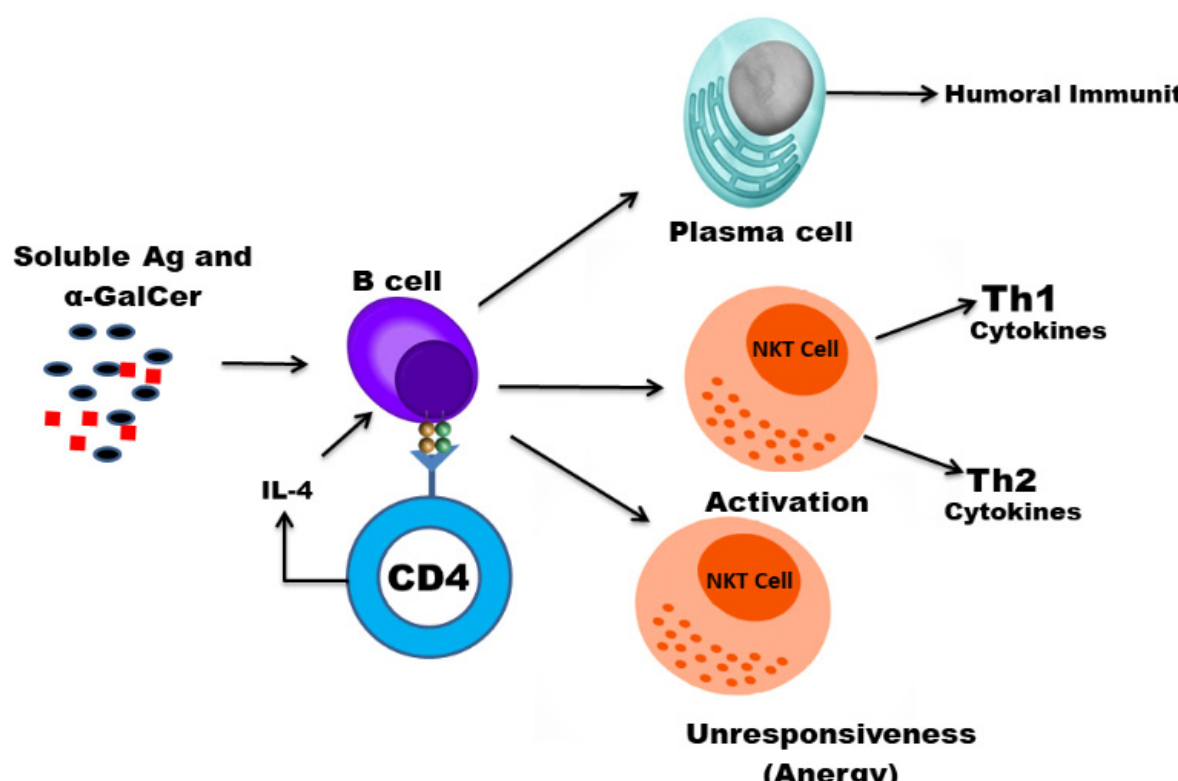
Figure 5. Soluble α -GalCer presented by B cells anergize NKT cells. In contrast to dendritic cells, α -GalCer-pulsed B cells express low levels of costimulatory molecules and anergize NKT cells.